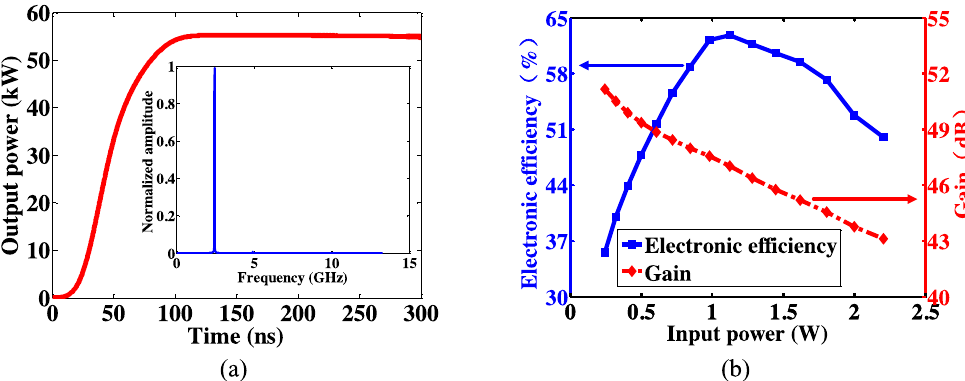
Fig. 10. PIC simulation results, (a) saturated output power of the 3-cavity MEIK at 2.453GHz (inset), and (b) electronic ef fi ciency and gain versus input power [48].